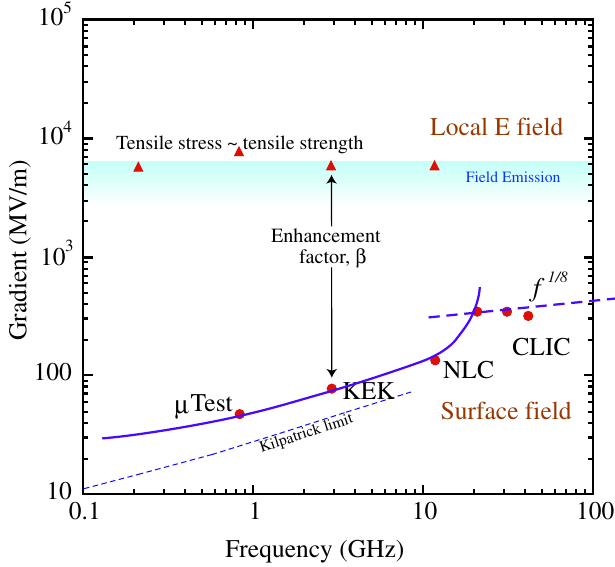
FIG. 15. (Color) The maximum surface field predicted by the model as a function of frequency (heavy solid line) plotted with the scaling at high current densities (heavy dashed line) [40] and the Kilpatrick limit